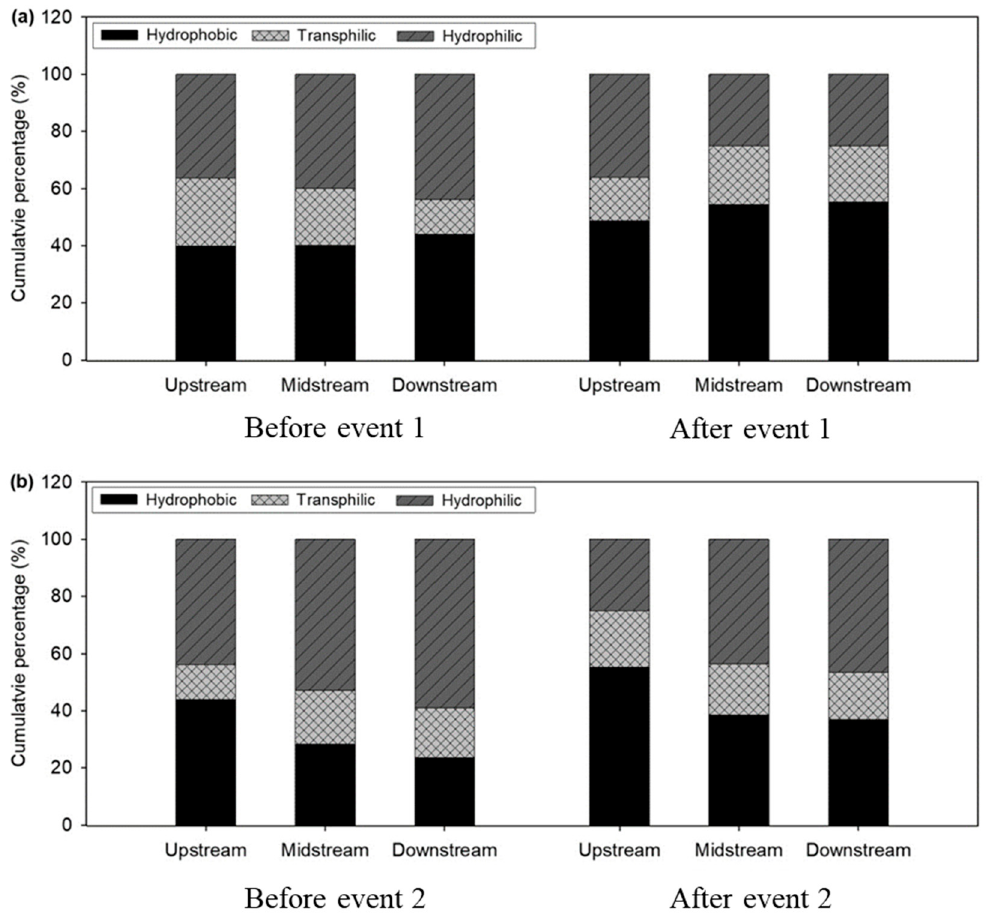
Figure 7. Hydrophobic (HPO), Transphilic (TPI), and Hydrophilic (HPI) composition of DOMs at each sampling point in ( a ) Event 1 and ( b ) Event 2.